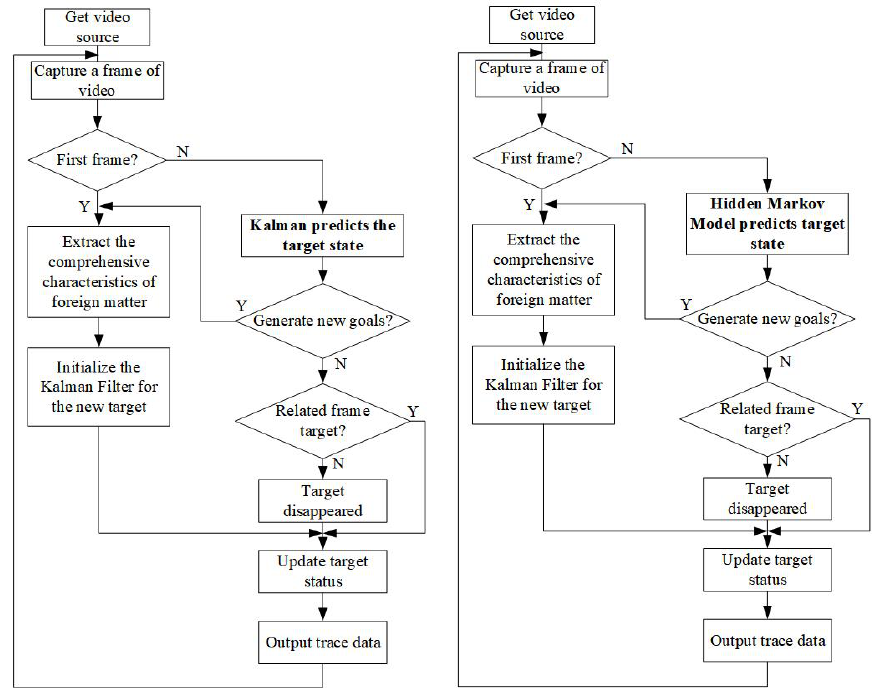
Fig. 1. The flow diagram of the system before and after the improvement